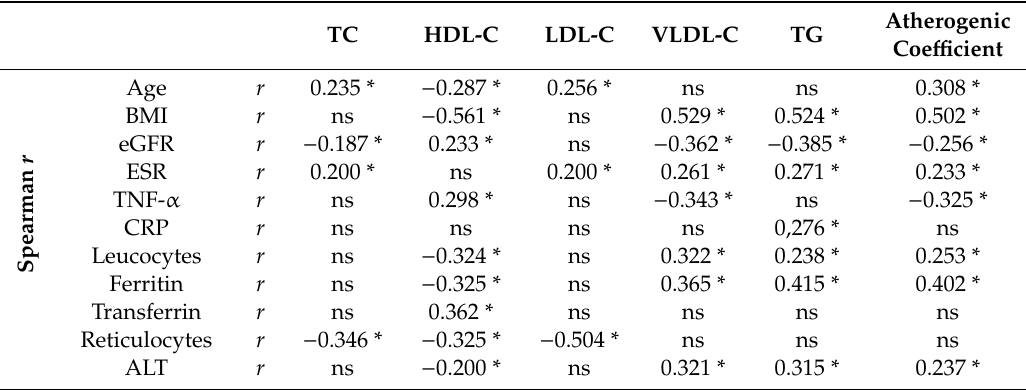
Table 5. Correlations between lipid profile, inflammatory markers and parameters of iron metabolism in patients with DM (independent of type).